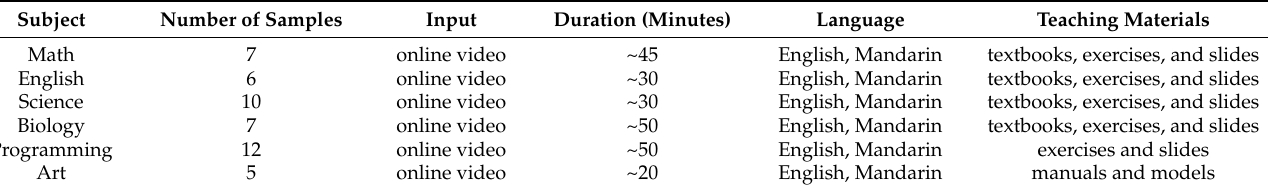
Table 2. Sample table of teacher training courses.